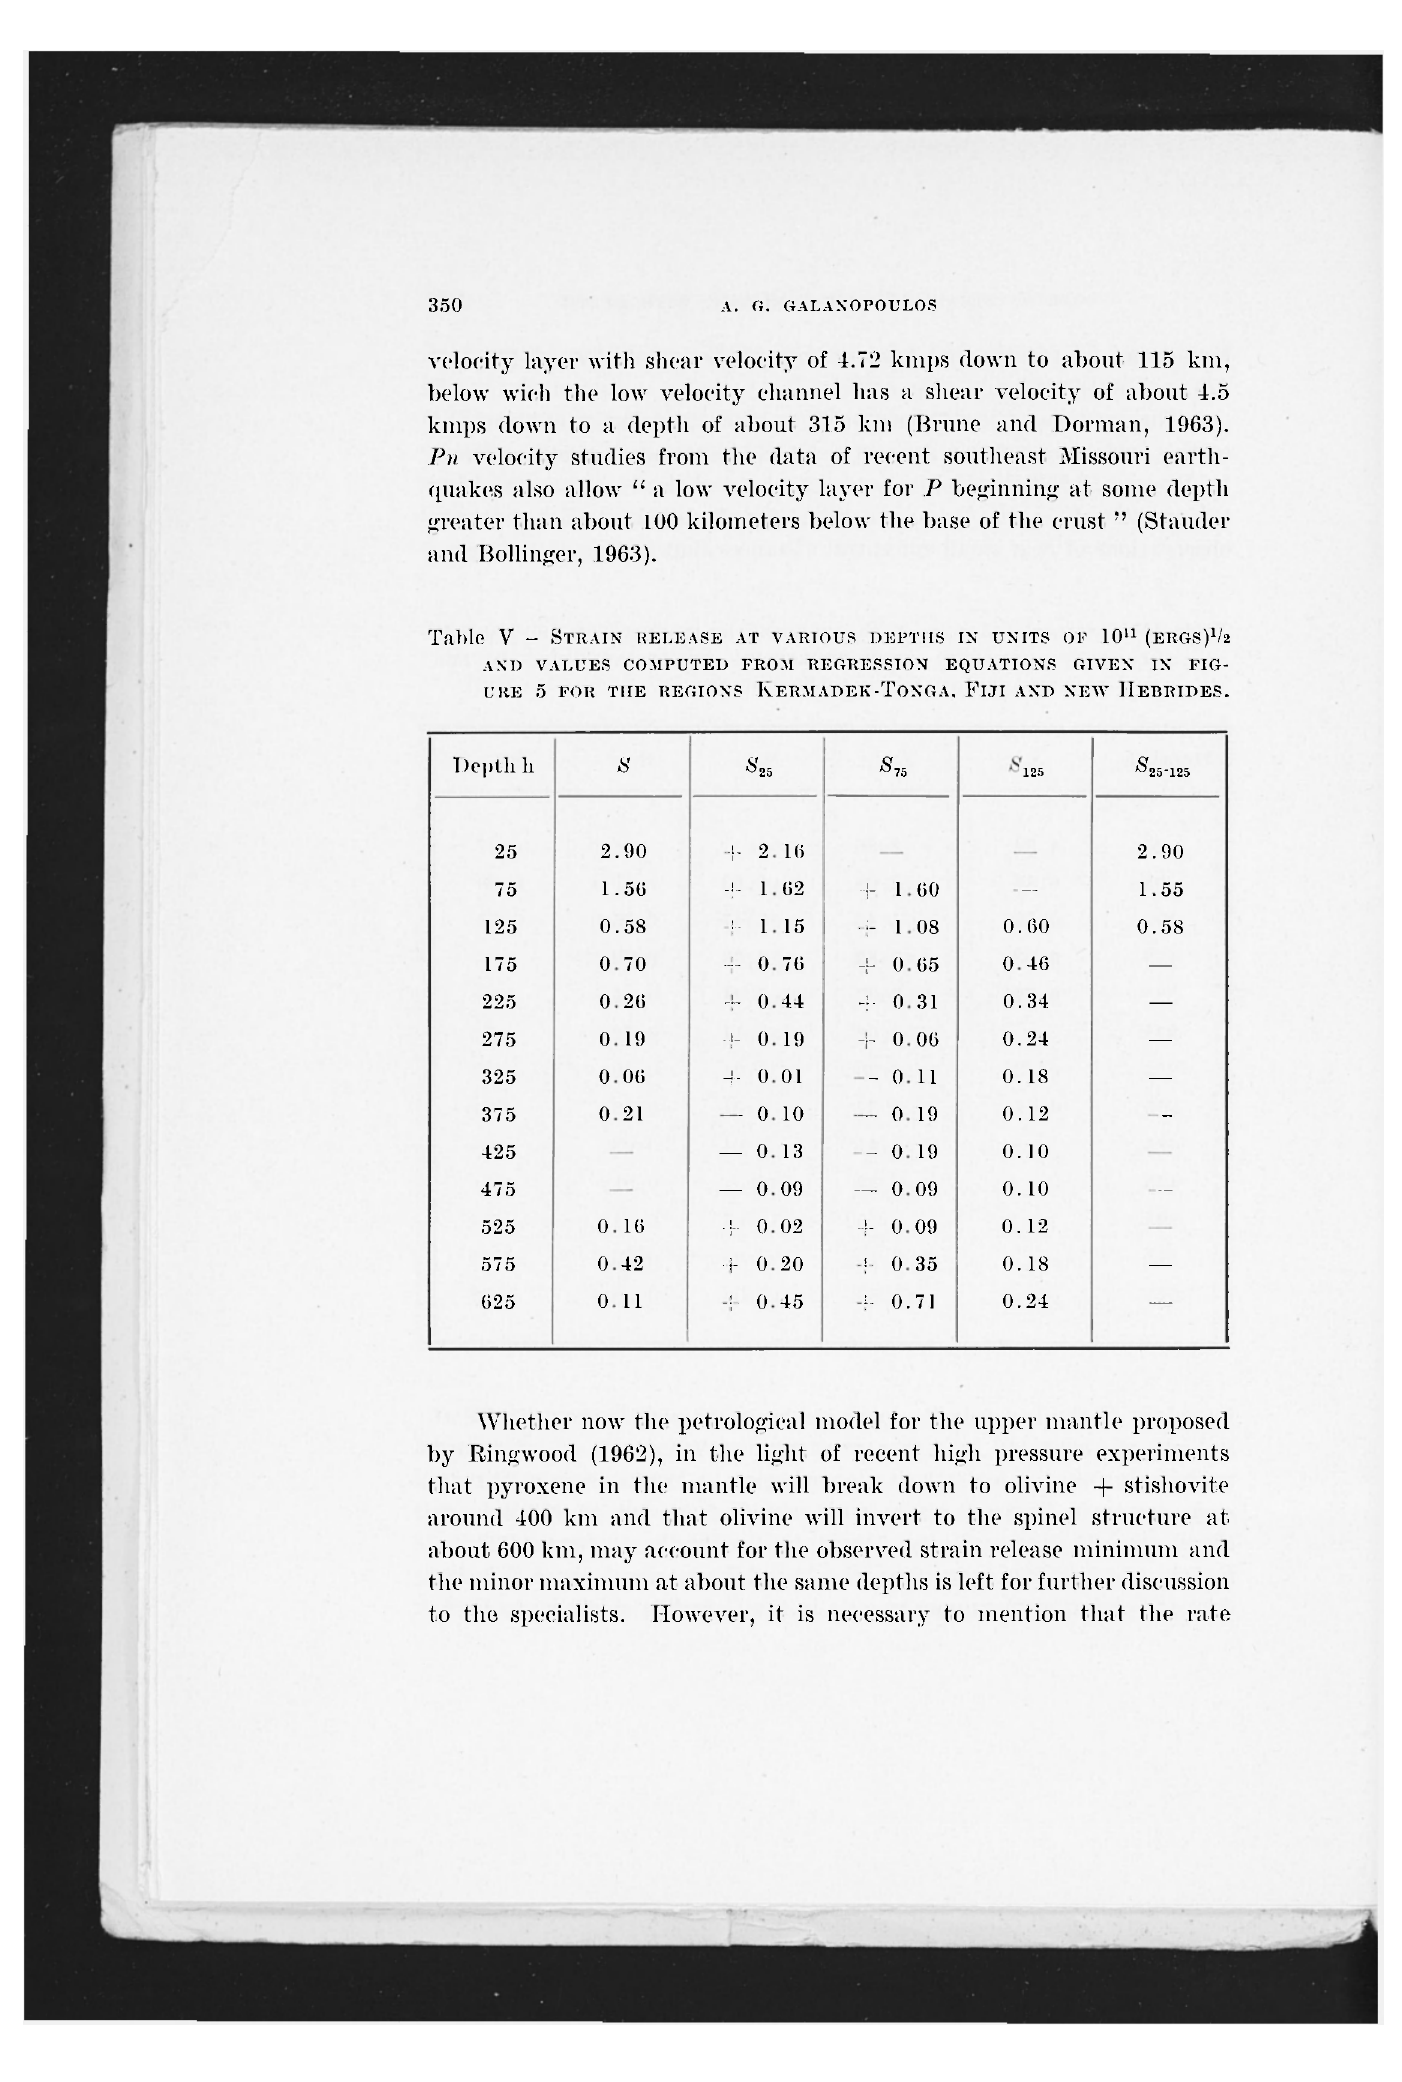
Table V - STRAIN RELEASE AT VARIOUS DEPTHS IN UNITS OF 10 11 (ERGS) 1 ^ AND VALUES COMPUTED FROM REGRESSION EQUATIONS GIVEN IN FIG- URE 5 FOR THE REGIONS IVERMADEK-TONGA, F i ji AND NEW HEBRIDES.